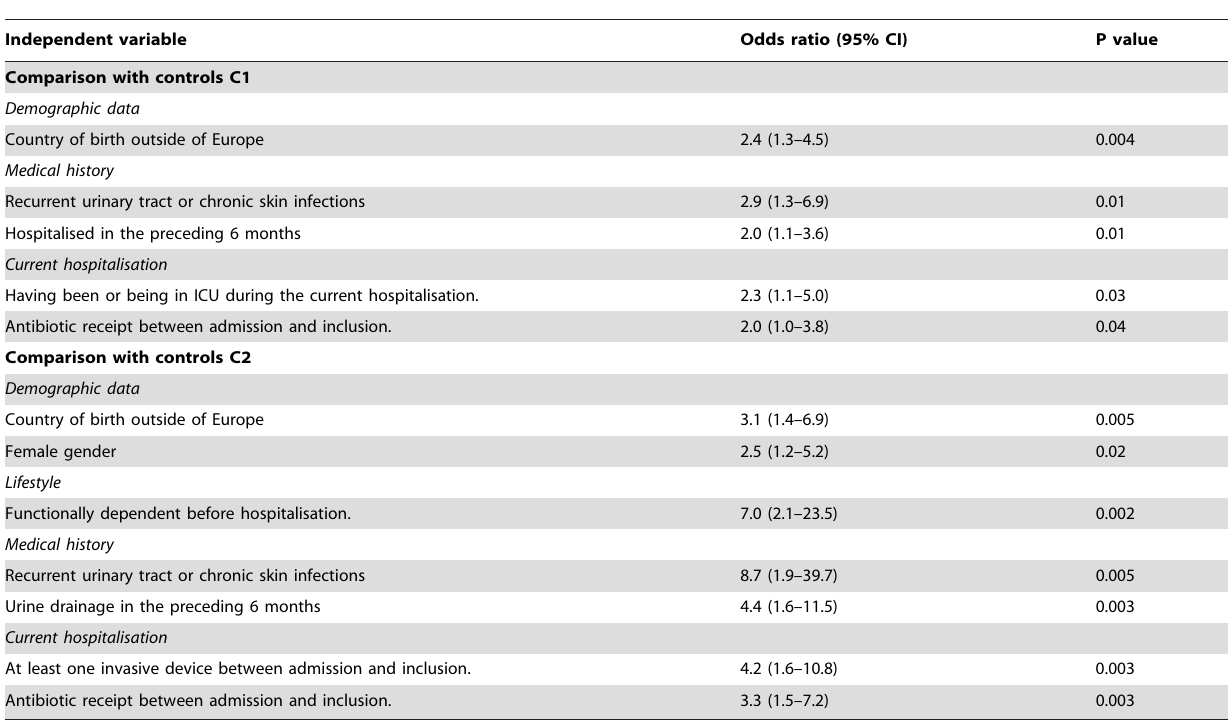
Table 4. Multivariate analysis of factors associated with a CTX-M-producing E. coli clinical